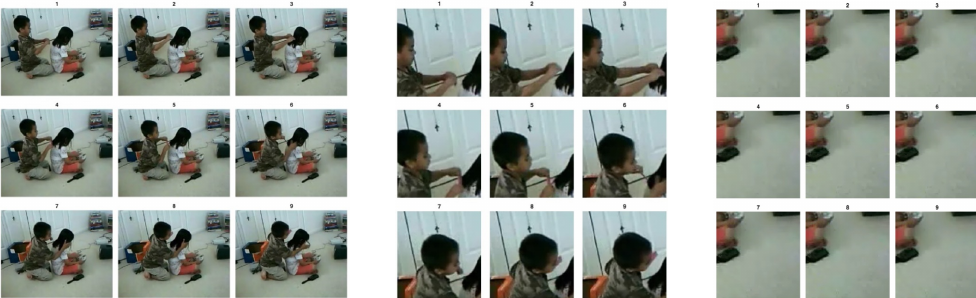
Figure 5. ( Left ): the frames of the shortened video; ( center ): result obtained by the proposed method; ( right ): the result of a bad random ROI